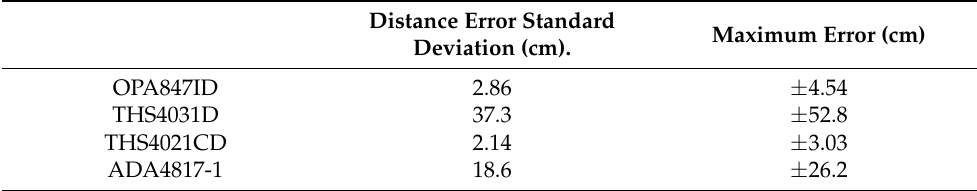
Table 4. Distance error due to OA (from Table 3). Rf = 22 K Ω , Cf = 1 pF + C FP = 1.2 pF. Left column: contributions are considered zero-mean and σ = 15% random variables. Right column: maximum deviation of error contributions of ± 15% (considering maximum signed